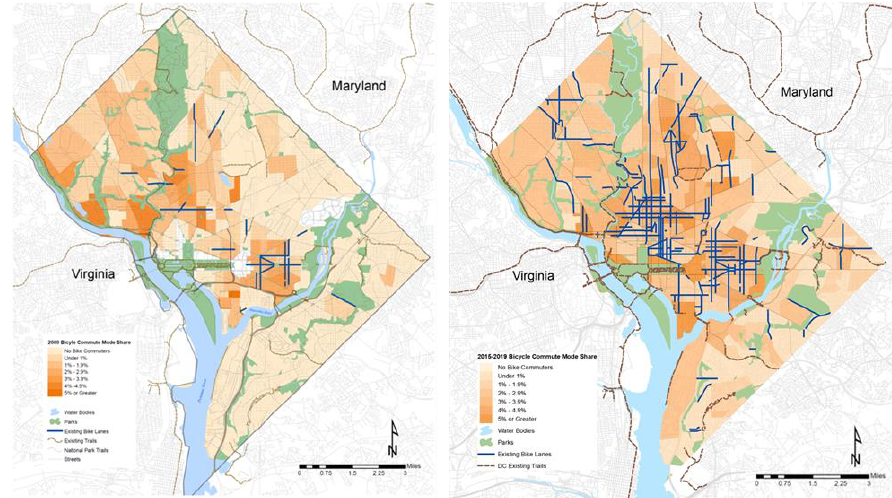
Figure 2. Bicycle commuting levels in Washington, DC (light brown to red background colors) and supply of bikeways on roads (blue lines) and shared-use trails (brown lines), 2000 ( left ) vs. 2019 ( right ). (Maps created for the authors by Dan Sonenklar (2000 map) and Brian Shelton (2019 map)) .